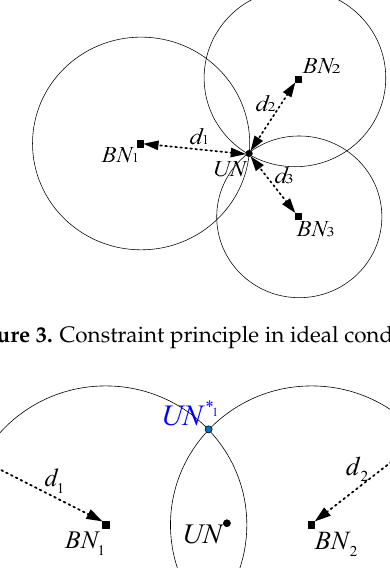
Figure 4. Single-objective constraint principle.